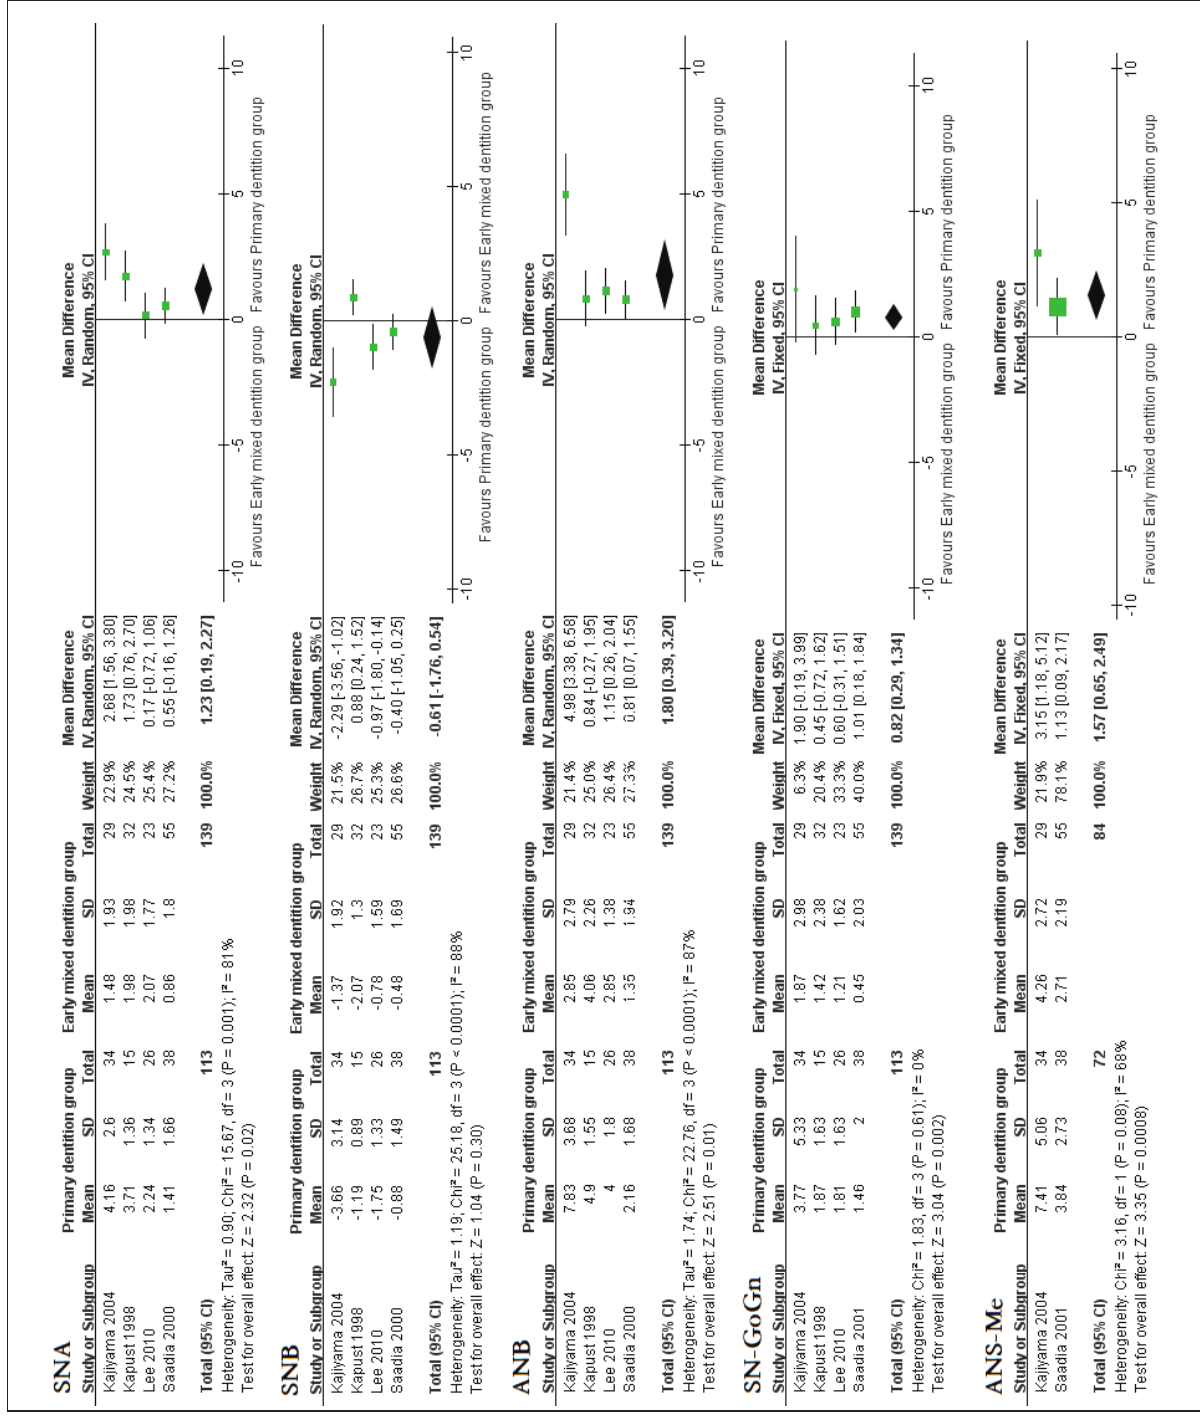
Figure 2. Meta-analysis between primary dentition and early mixed dentition. The efficacy assessment of the primary dentition group for Class III malocclusion versus the early mixed dentition group. The comparison was performed using five indices. 1: Angle SNA. The primary dentition group presented a greater increase in SNA than the early mixed dentition group (MD = 1.23, 95% CI = 0.19 – 2.27, P = 0.02). 2: Angle SNB. There were no significant differences in SNB between the primary dentition group and the early mixed dentition group (MD = -0.61, 95% CI = -1.76 – 0.54, P = 0.30). 3: Angle ANB. The primary dentition group presented a greater increase in ANB